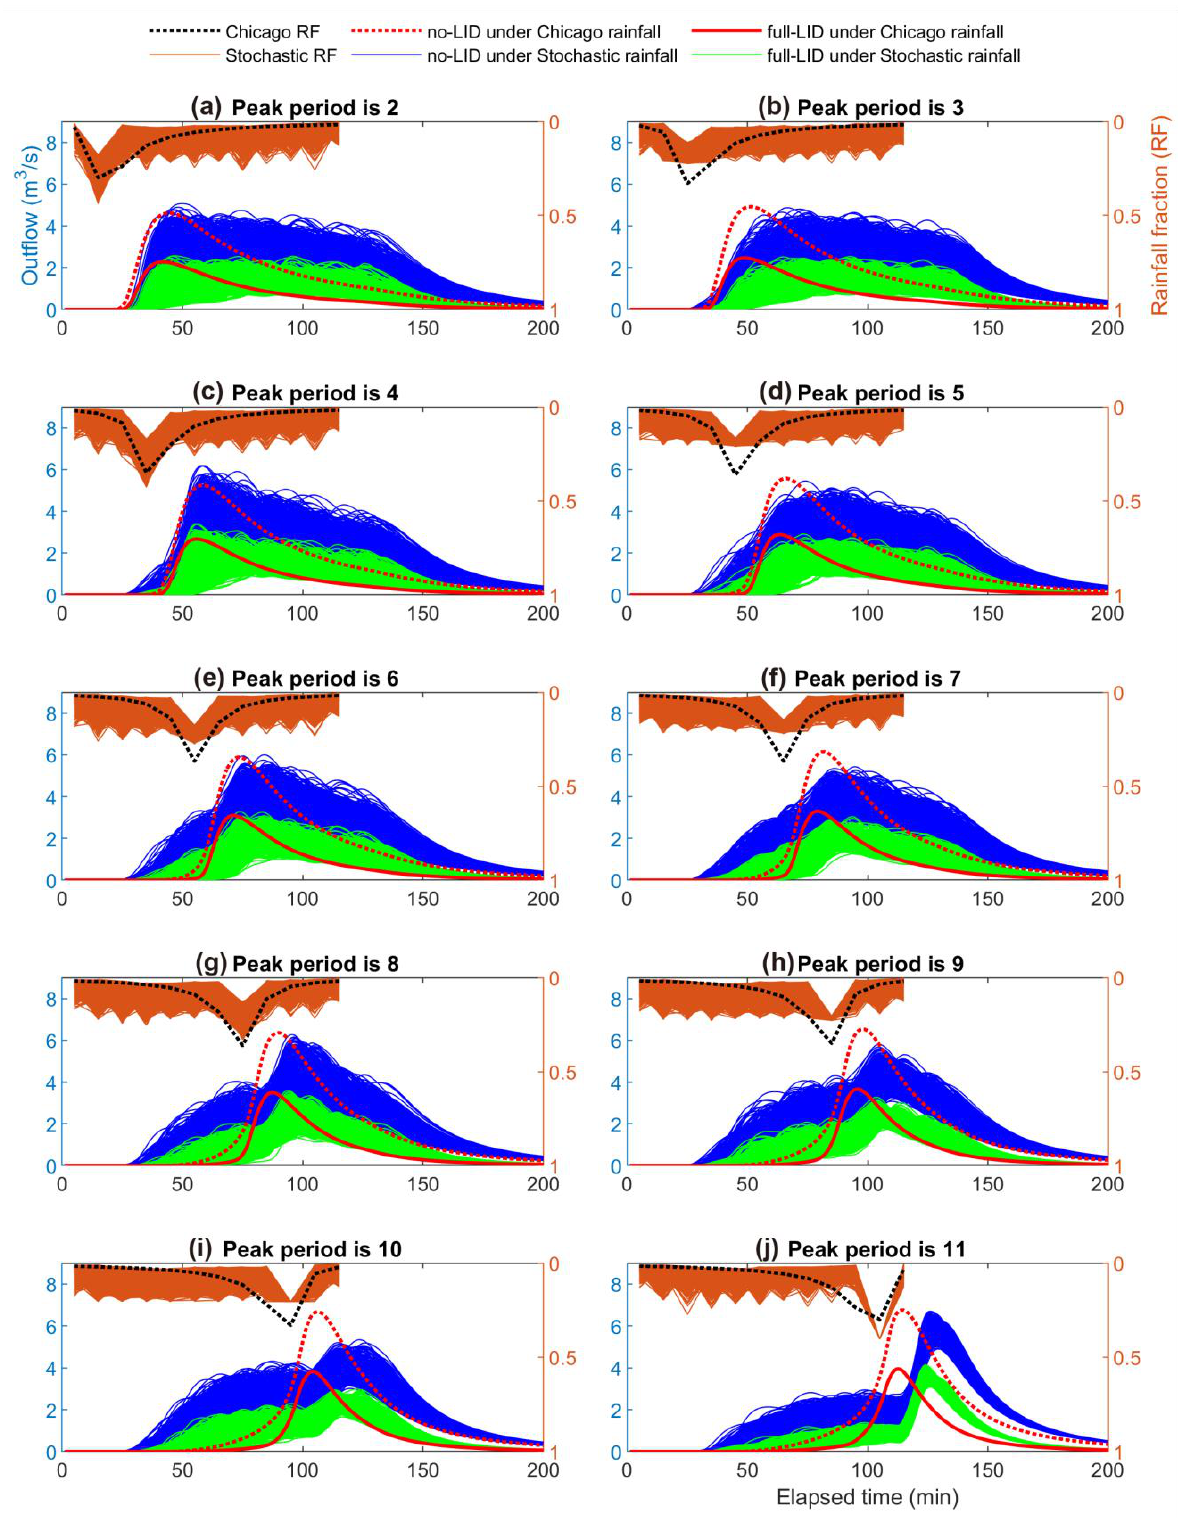
Figure 4. Rainfall fraction and catchment outflow time series in no- and full-LID scenarios under Chicago and stochastic precipitation events. The no-LID denotes low-impact development facilities (LIDs) are not constructed, and full-LID denotes LIDs are constructed as much as possible.